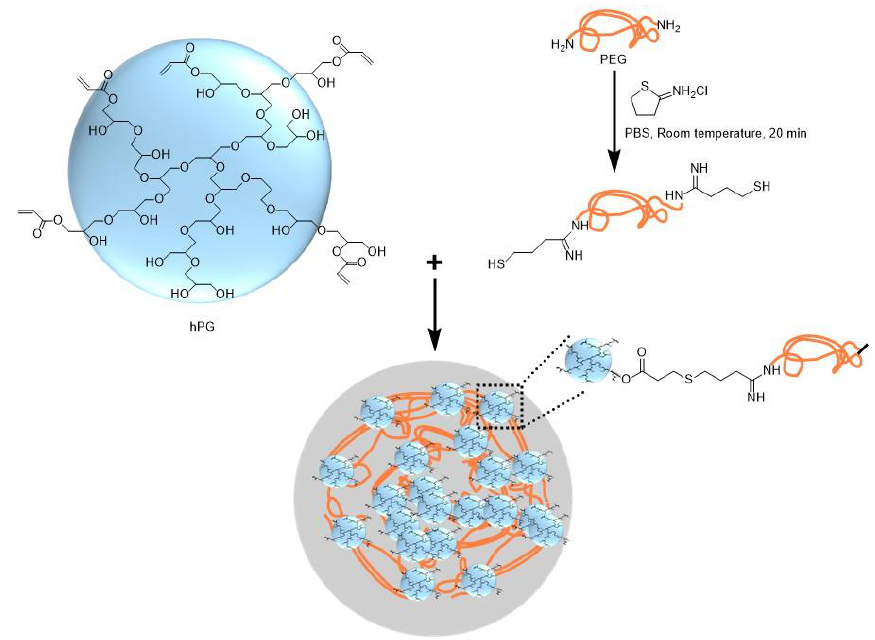
Figure 21. Synthesis of PEG-dithiol by reacting PEG-diamine and 2-iminothiolane and the forma- tion of the microgel by the crosslinking of PEG-dithiol and acrylated hyperbranched polyglycerol (hPG)